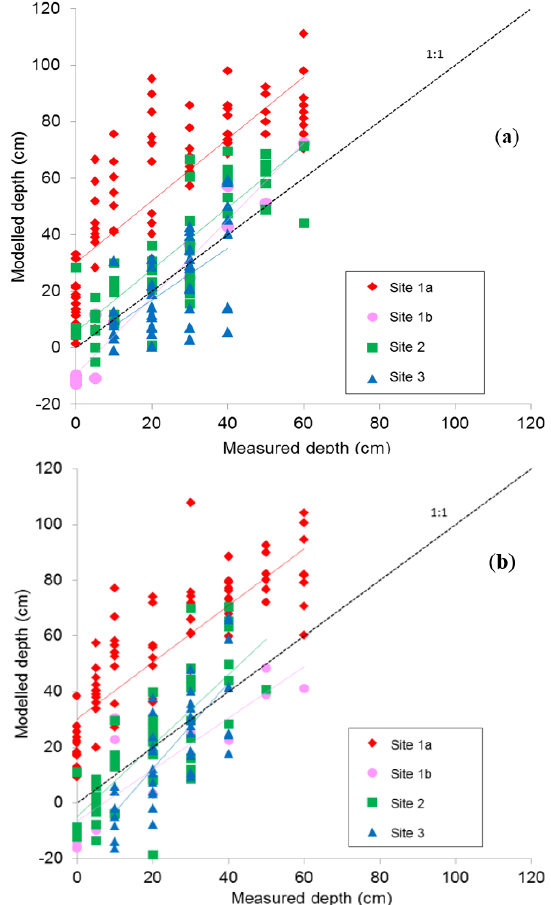
Figure 7. Depth estimated with ( a ) NIR(R72) model and ( b ) Red/BP2 ratio model versus measured depth for samples from site 1a (♦; n = 87), site 1b (●; n = 84), site 2 (■; n = 47) and site 3 (▲; n = 30). Dashed line indicates 1:1 line. All shown model coefficients are significant at α =